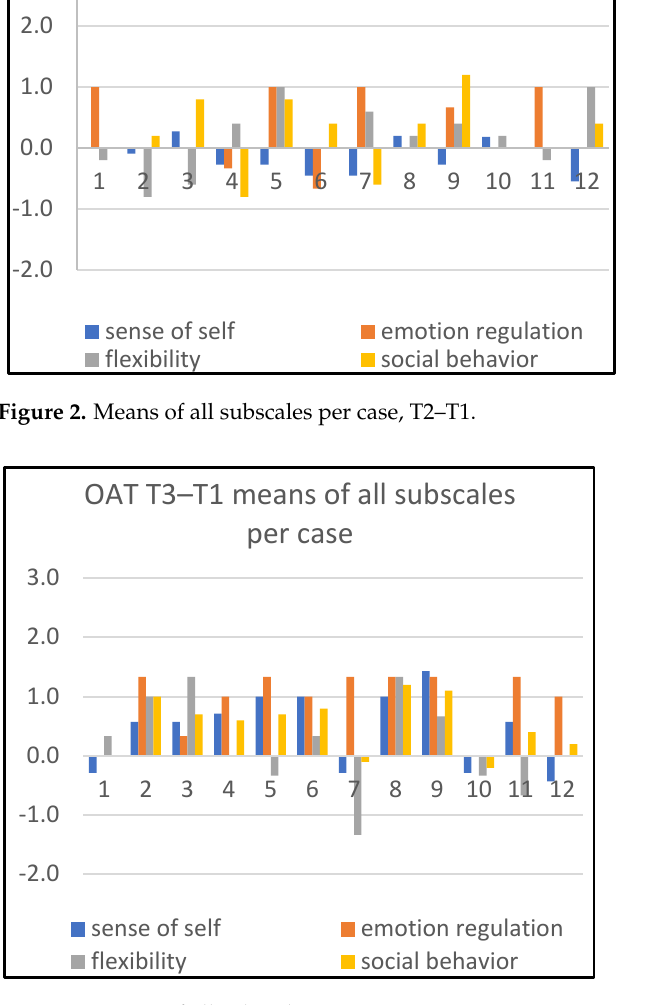
Figure 3. Means of all subscales per case, T3–T1.